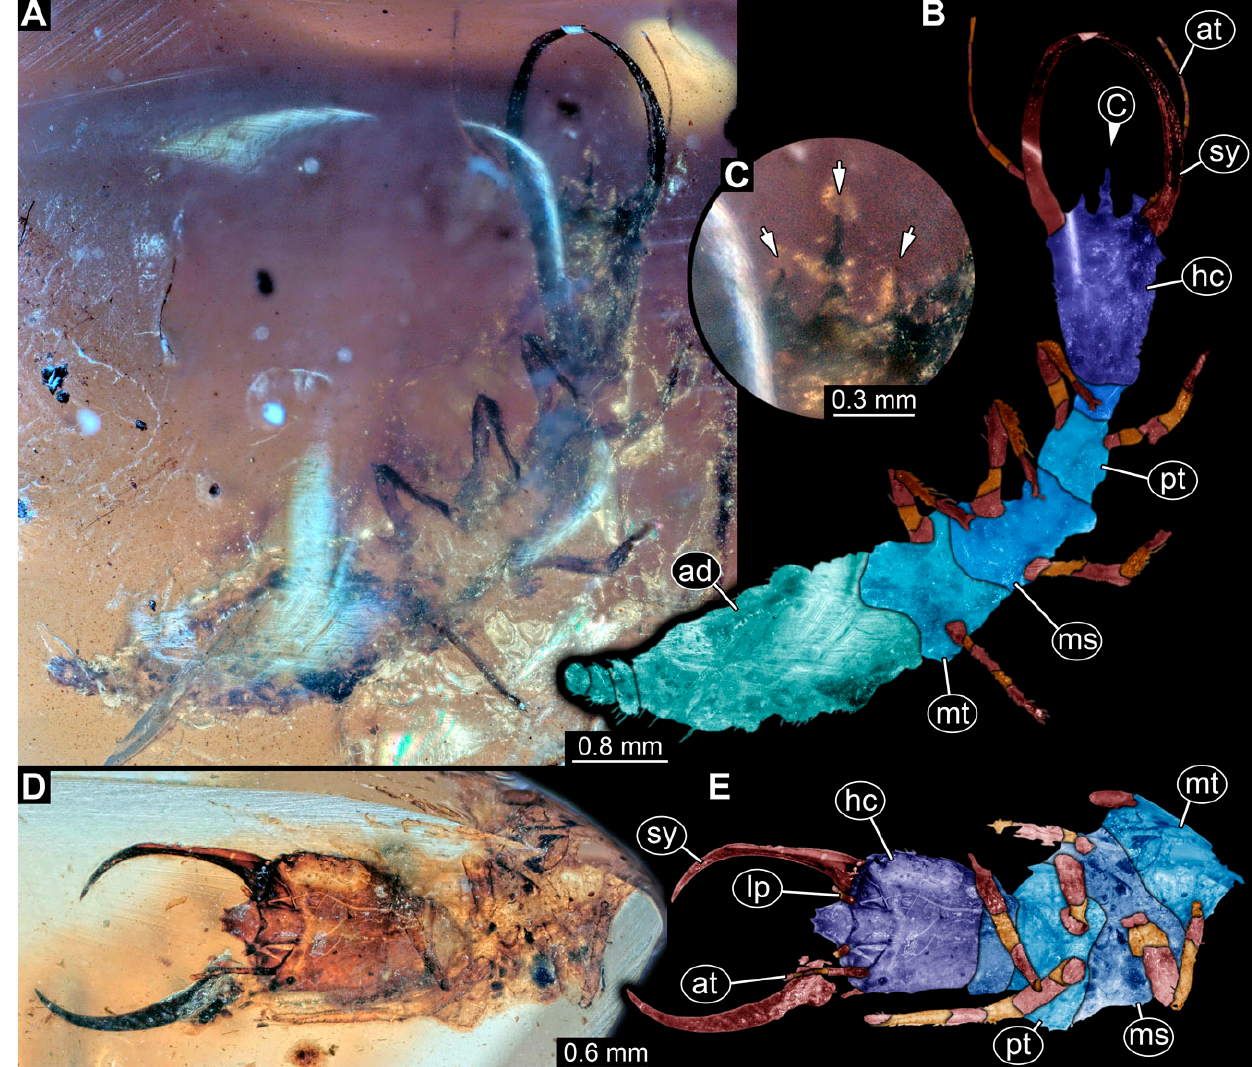
Figure 6. Specimens in Myanmar amber. ( A – C ) Specimen 65 (PED 0612). ( A ) Ventral view. ( B ) Ventral view, colour-marked. ( C ) Close-up of labrum in dorsal view; arrows mark spine-like protrusions. ( D , E ) Specimen 59 (PED 0412). ( D ) Ventral view. ( E ) Ventral view, colour-marked. Abbreviations: ad = abdomen; at = antenna; hc = head capsule; lp = labial palp; ms = mesothorax; mt = metathorax; pt = prothorax; sy = stylet.